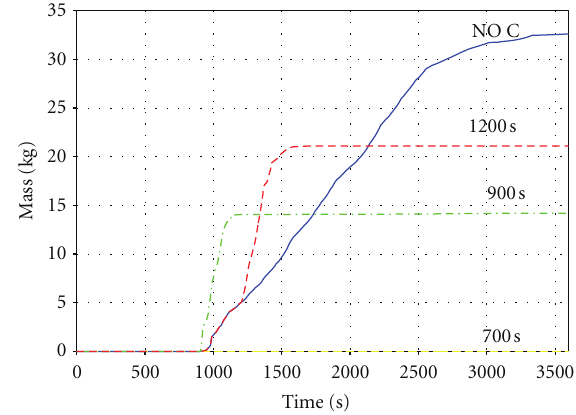
Figure 9: Noncondensable fission product released. HPCS injection to 700 s, 900s, and 1200 s; NO C indicates without HPCS